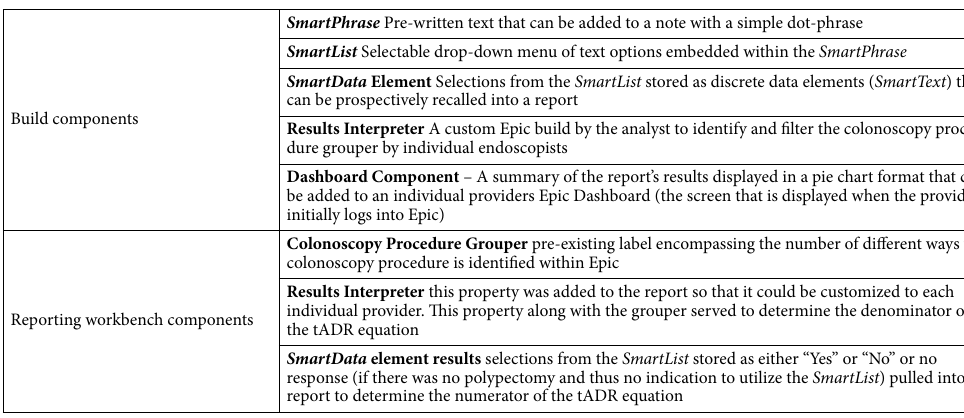
Table 1. Build Components and Report Components required for the Epic based tADR